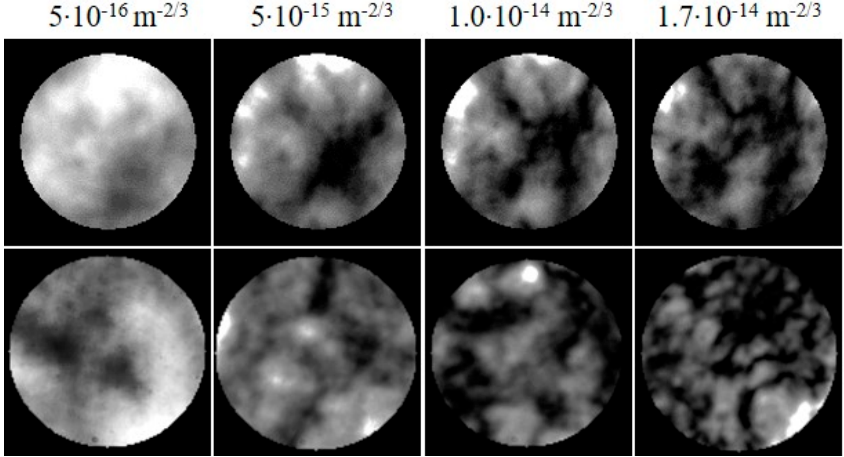
Figure 4. Examples of selected scintillation images from SIM- Kolmogorov (KO) ( top row ) and ATM#1 ( bottom row ) datasets corresponding to di ff erent turbulence strengths as indicated by C 2 n values above each column.